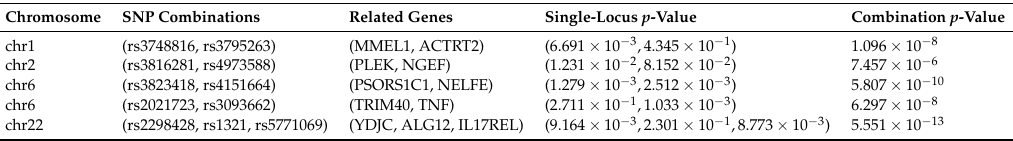
Table 2. Significant two-locus and three-locus combinations identified by ClusterMI on the WTCCC celiac disease (CD)